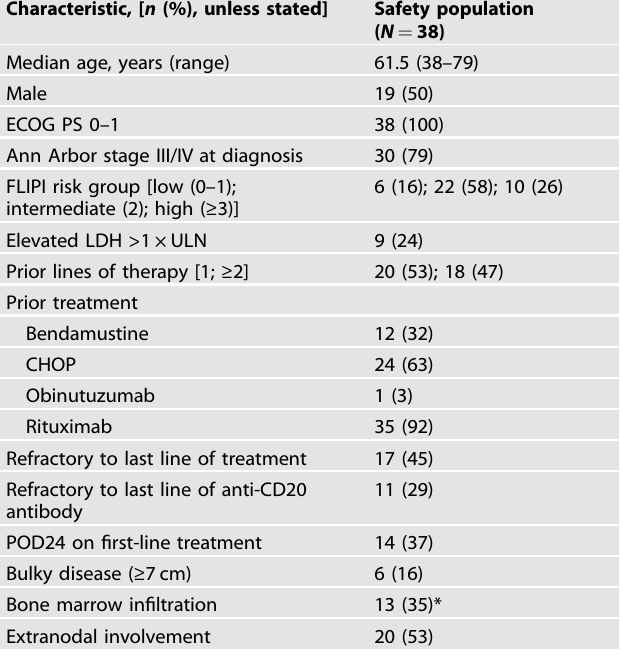
Fig. 1 Patient disposition ( fi nal analysis). AE, adverse event; atezo, atezolizumab; G, obinutuzumab; L, lenalidomide; PD, progressive disease. Table 1. Baseline characteristics (safety